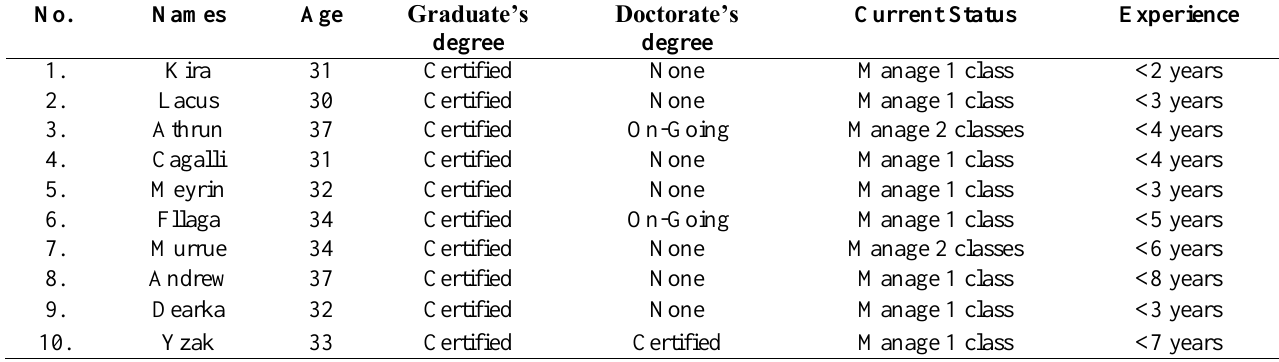
TABLE 1 | Contributor’s associated data No.